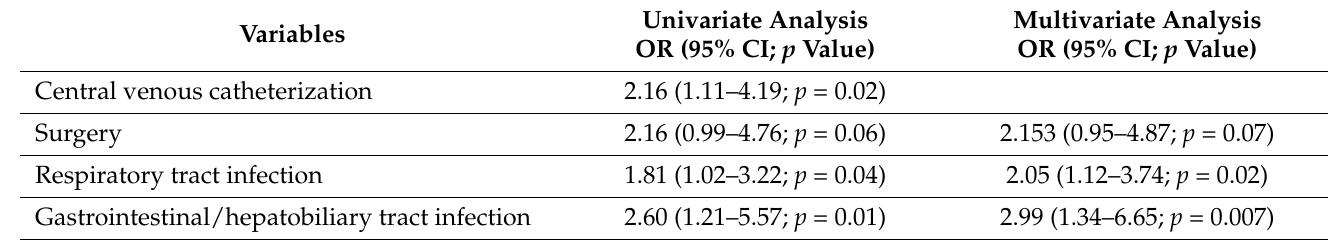
Table 4. Multivariate analyses of factors associated with CRE acquisition during hospitalization.